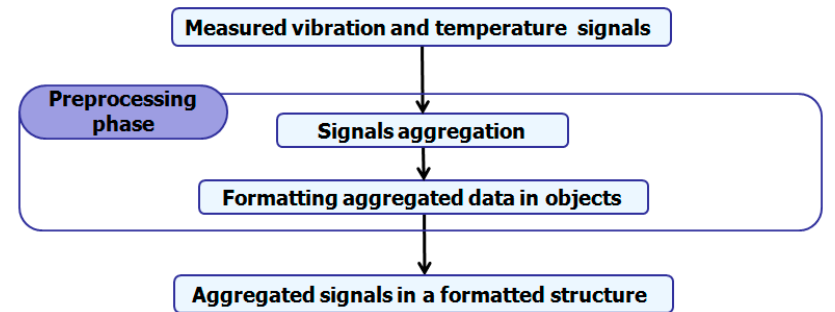
Figure 2. Workflow of the preprocessing phase.